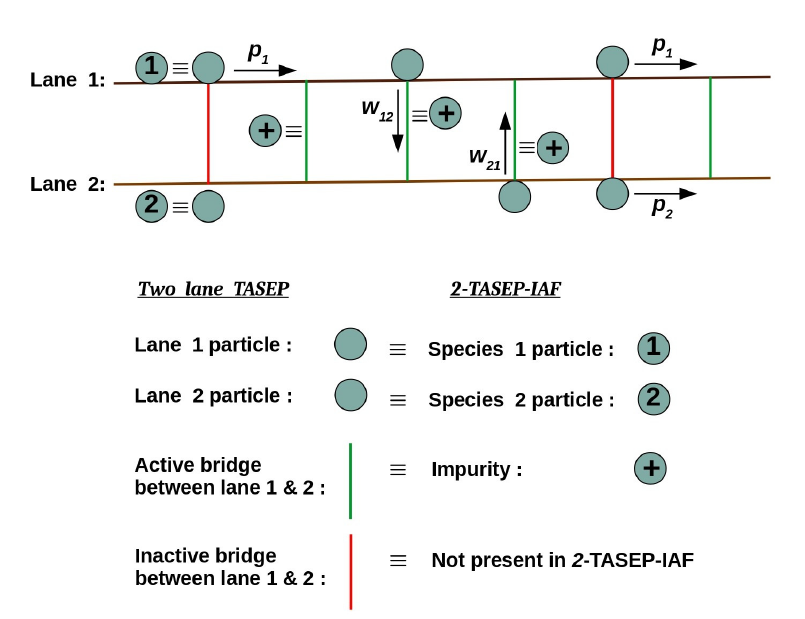
Figure 11: The figure illustrates a two lane totally asymmetric simple exclusion pro- cess and the identification of its components to the equivalent constituents of the